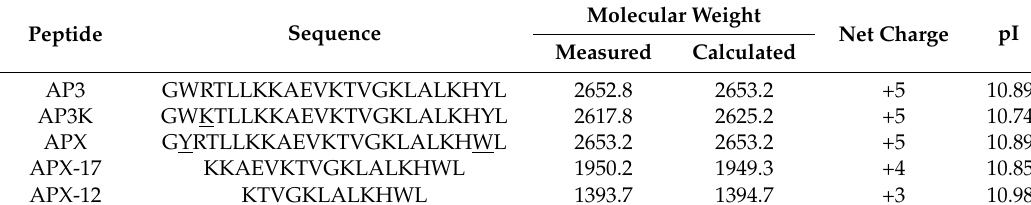
Table 1. Peptide Sequences and Properties.